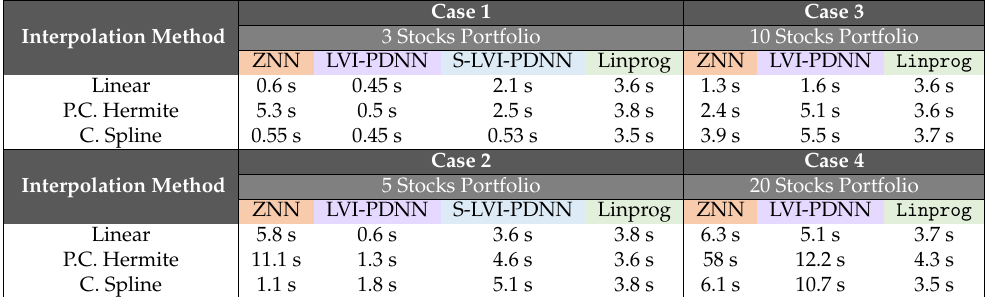
Table 1. The NNs’ and MATLAB’s solver time consumption for solving the MCPI